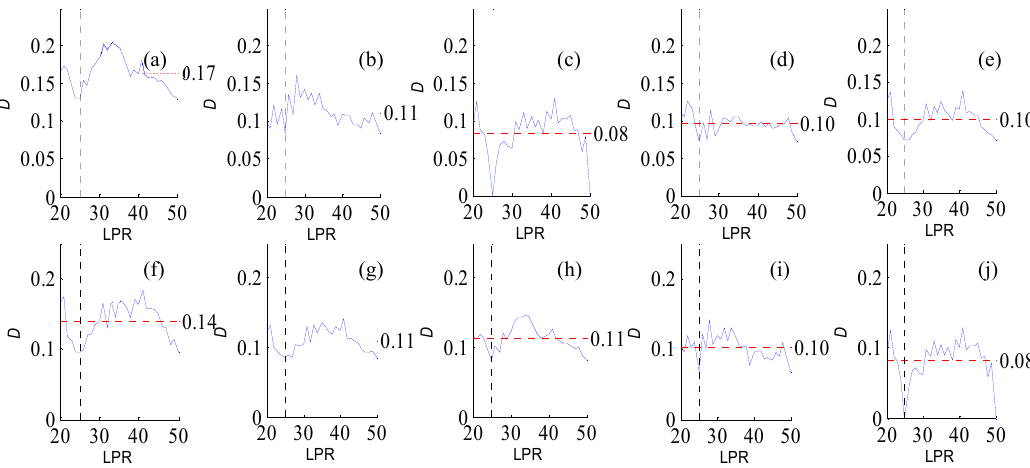
Figure A2. Variation of flow regime alteration degree (D) measured by the RVA with change in the length of post-impact flow time series (LPR) under a periodicity of 25 years. Figure ( a ), ( b ), ( c ), ( d ), ( e ), ( f ), ( g ), ( h ), ( i ), and ( j ) correspond to pre-impact flow time series length = 18, 21, 25, 29, 32, 36, 39, 43, 46, and 50 years, respectively. The abscissa value for the vertical dotted line is 25. The ordinate value for the horizontal dotted line is the mean degree of flow regime alteration in each subfigure.